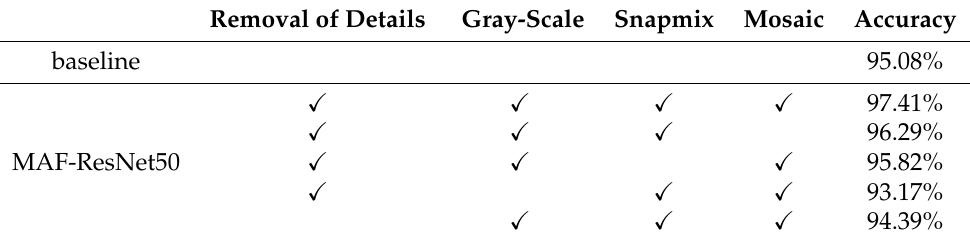
Table 4. Ablation experiment result of different pre-processing methods.